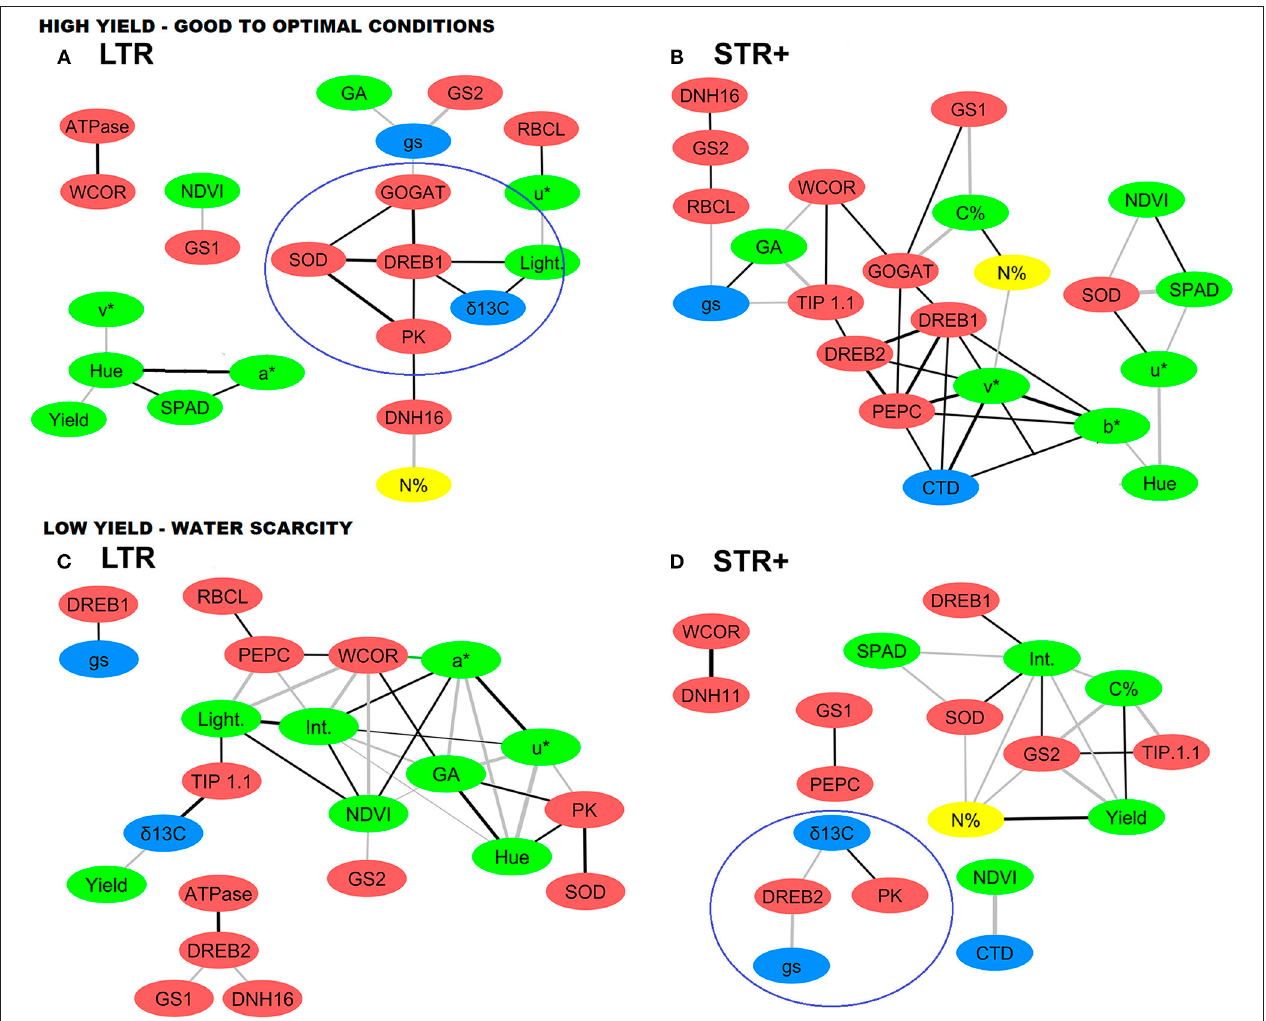
FIGURE 3 | Network analysis of agronomic and physiological traits and transcript levels of very segmented transpiration (STR + ) and linear transpiration (LTR) durum wheat lines under (A,B) high (HY) and (C,D) low (LY) yield environments. Each yield environment includes data of two trials (i.e., growing conditions) at different locations. Red nodes represent transcript levels, green nodes vegetation indices and carbon content, blue nodes water status traits and yellow nodes N content. The black and gray connecting lines (edges) represent significant positive and negative correlations ( p < 0.05), respectively, based on Pearson’s correlation coefficients in which thickness corresponds to the width of the edges (0.7, thinner to 1, thicker). For each of the two groups of lines (STR + and LTR) with different transpiration patterns, and within a given yield environment (HY and LY), the values used in the network analysis for the different agronomical, physiological and transcription traits were the result of combining all the lines within a transpiration group, with each individual line having three biological (plot) replications per trial. For trait and transcript abbreviations see Tables 4, 5